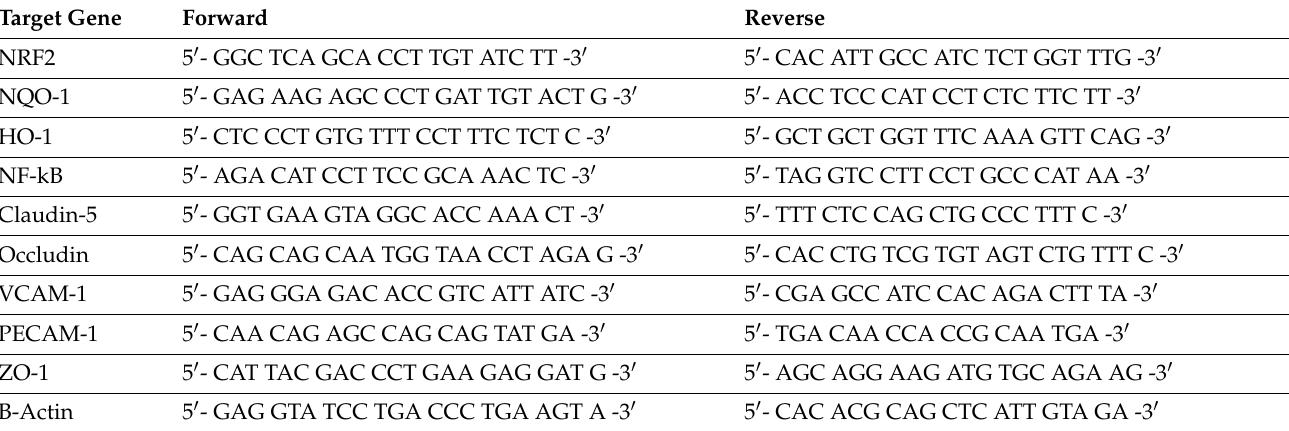
Table 2. Forward and reverse primer sequences (5 (cid:48) -3 (cid:48) ) for quantitative